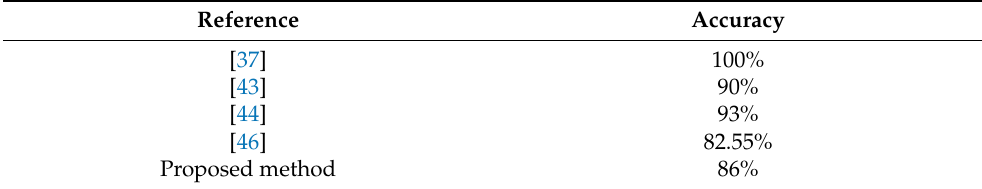
Table 5. Comparison with different